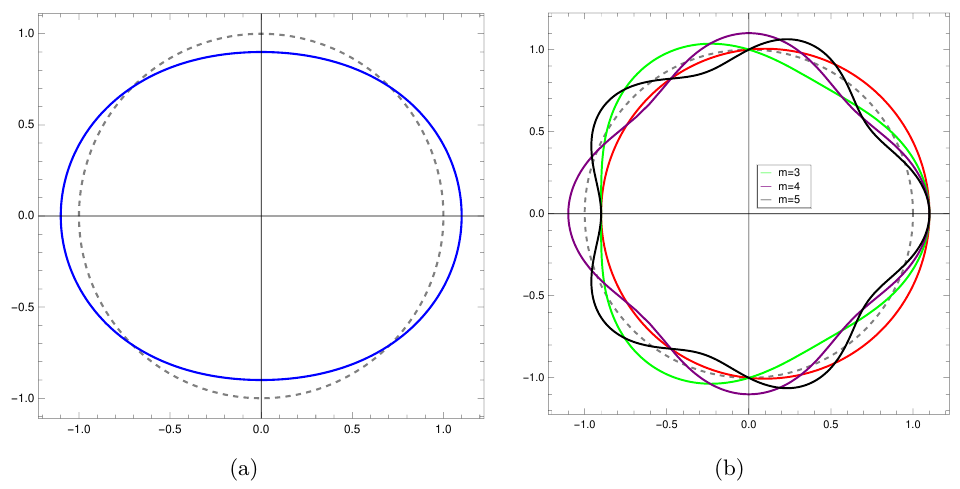
Figure 6 . (a) Deformation of a circle (dashed gray) into an ellipse (blue). (b) Deformations from the circle (dashed gray) to other curves, using a deformation δX r = Rε cos( mθ ) . Here we fixed ε = 0 . 1 and R = 1 . The red curve corresponds to m = 1 . Since it is simply a shift of the original circle, it does not contribute to the deformation of the partition function in eq.